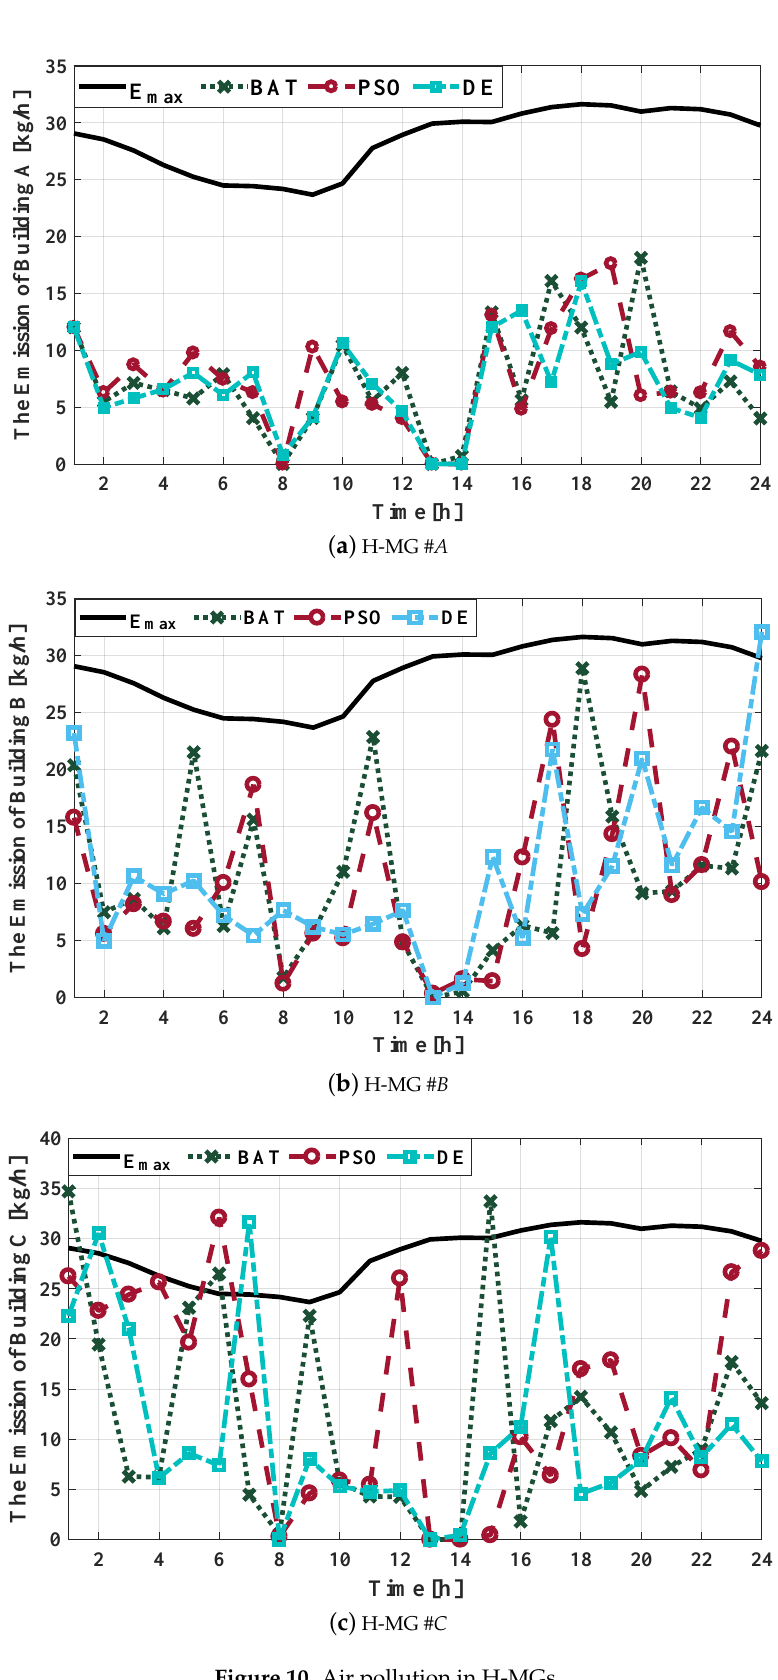
Figure 10. Air pollution in